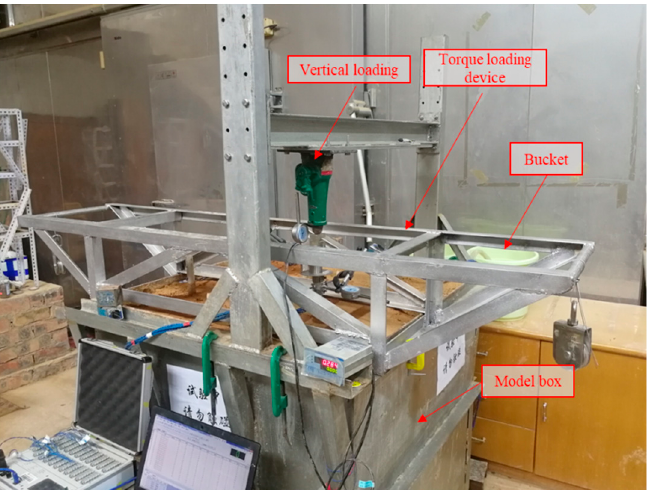
Figure 6. Test device diagram.